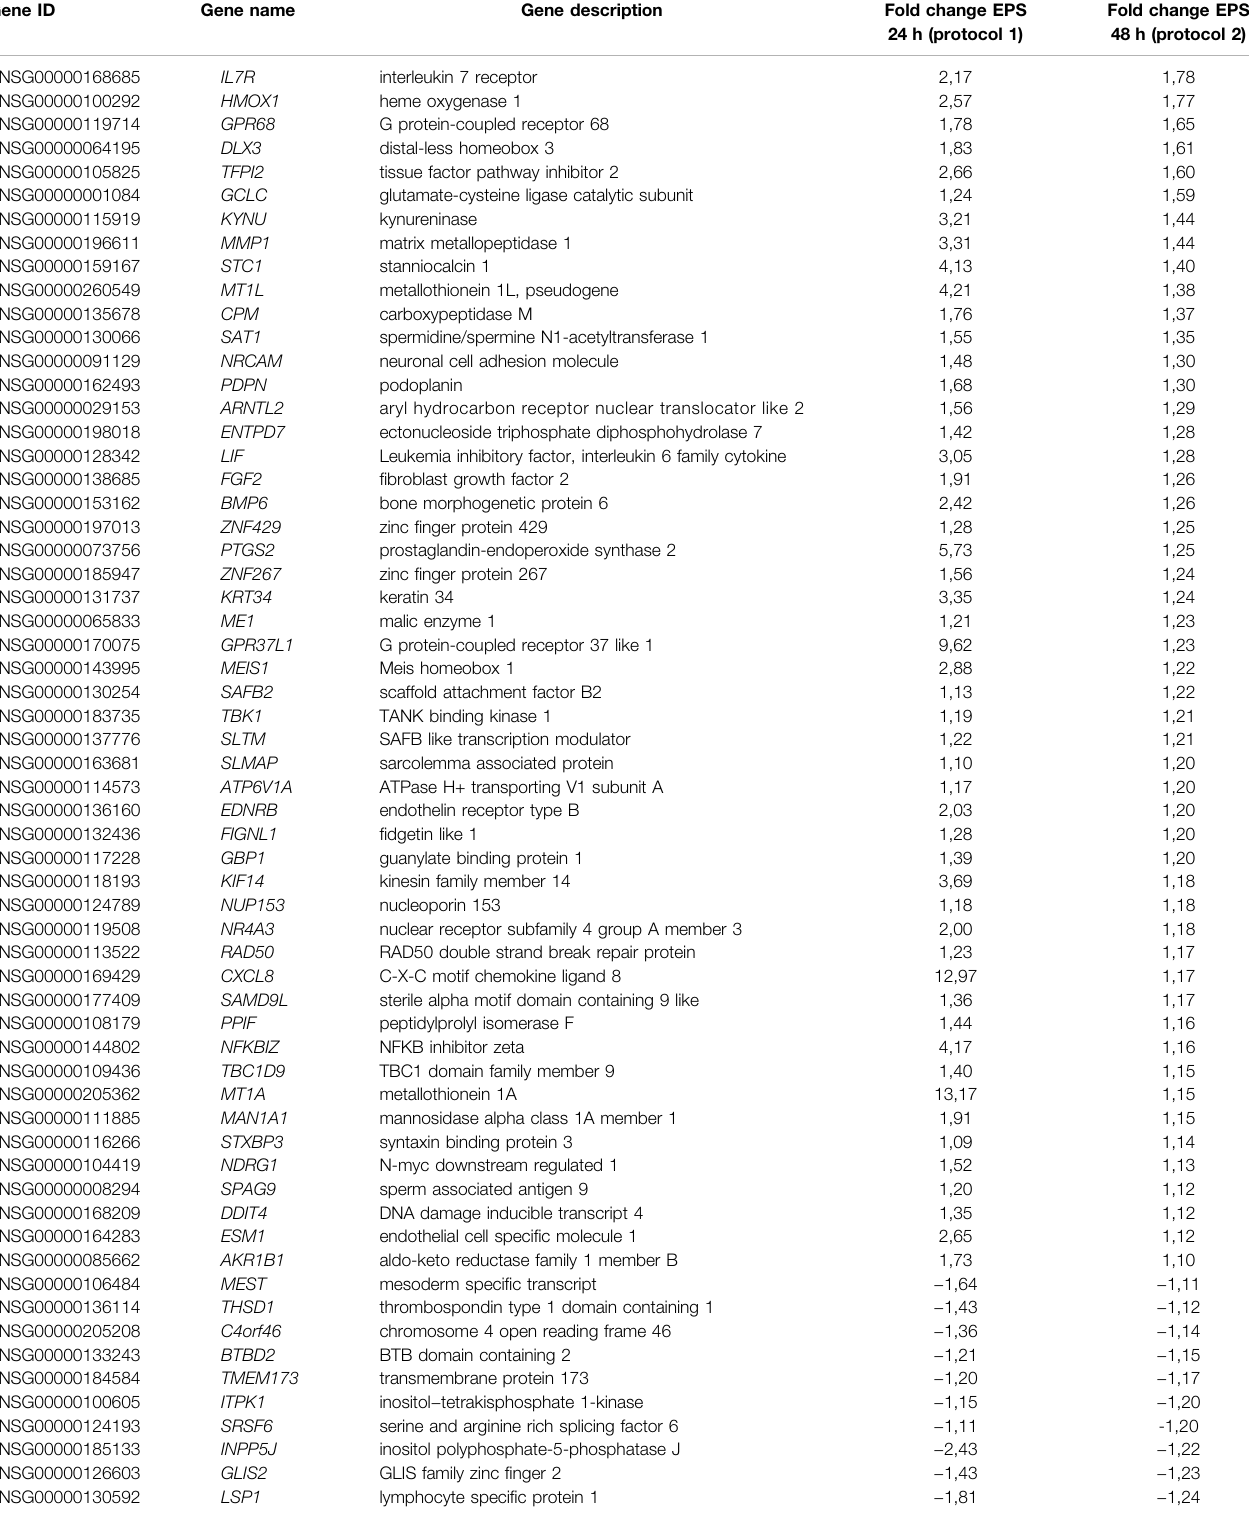
TABLE 3 | Regulated overlapping genes between EPS-treated myotubes from young male subjects and middle-aged women obtained from RNA sequencing and microarray platforms. Gene